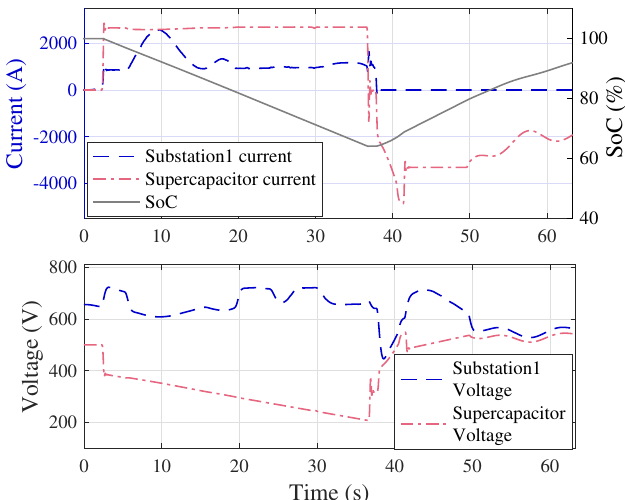
Figure 17. Substation1 and SC Current, SC SoC, Substation1 and SC Voltage for 45% energy saving with standalone SCESS.